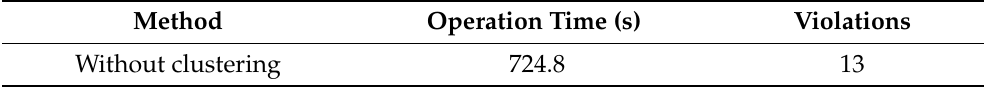
Table 3. Number of violations when considering a single set of